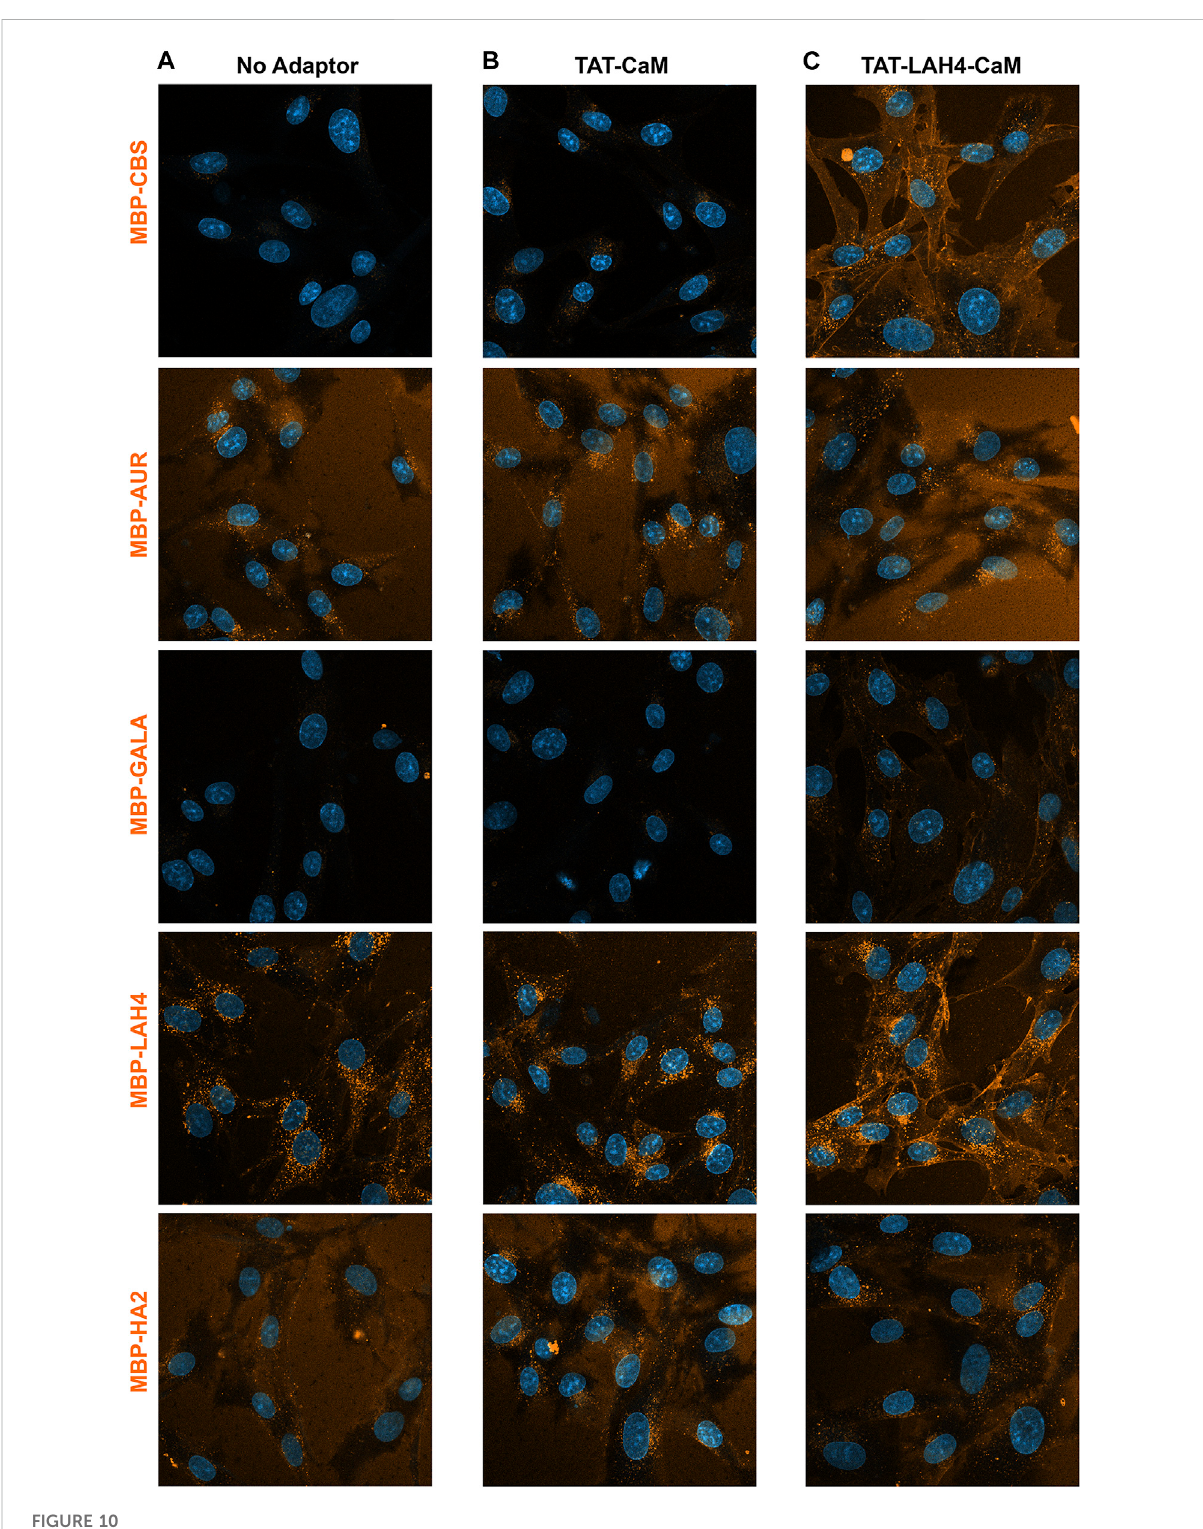
FIGURE 10 Direct comparison of internalization ef fi ciencies for fi ve 550-labeled MBP-EP-CBS cargos: MBP-CBS, MBP-AUR, MBP-GALA, MBP-LAH4, and MBP-HA2. Cargo alone and adaptor/cargo complexes (1 µM) were internalized in growth media for 1 h prior to washing (PBS x2) and imaging in media containing NucBlue. Internalization of the 5 substrates was concurrently analyzed in (A) with no adaptor present, in (B) with TAT-CaM and in (C) with TAT-LAH4-CaM. The individual experiments represented by each column were independently adjusted to accent pattern differences within each column (for direct comparison of adaptors see Figures 7 –